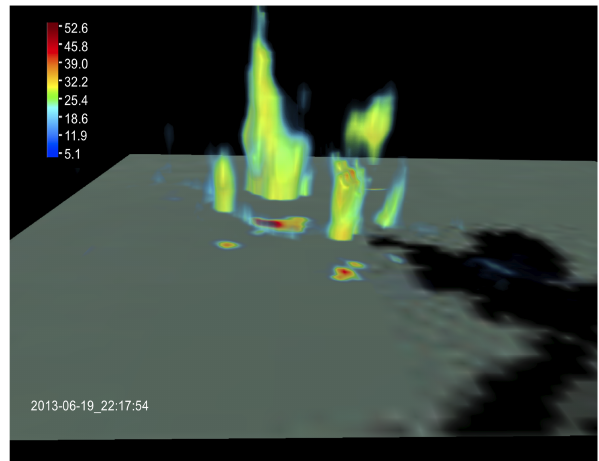
Figure 1. A 3D structure snapshot of radar reflectivity (unit:dBZ) from NEXRAD, overlaid with the composite reflectivity shown on the surface at the time when the maximum reflectivity is observed (22:17UTC). The dark shade shows the water body, and the largest cell is in